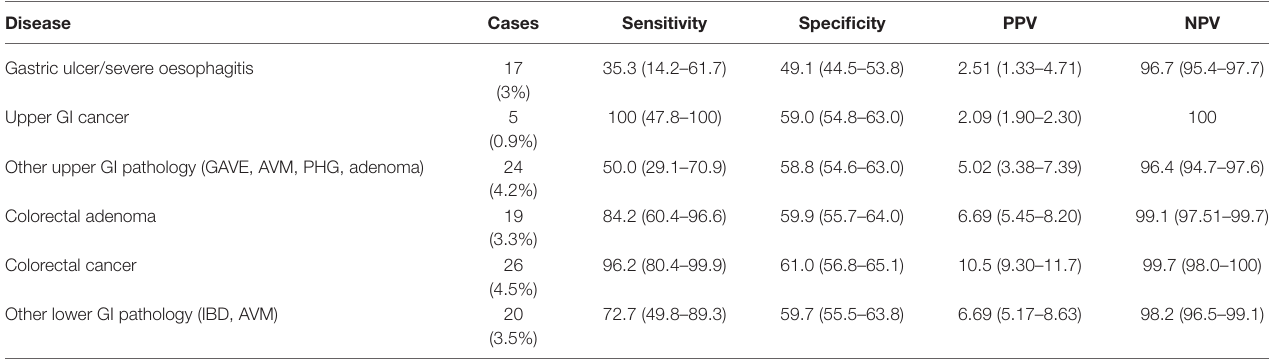
TABLE 3 | Diagnostic performance of qFIT for ANLs and additional significant GI pathology.